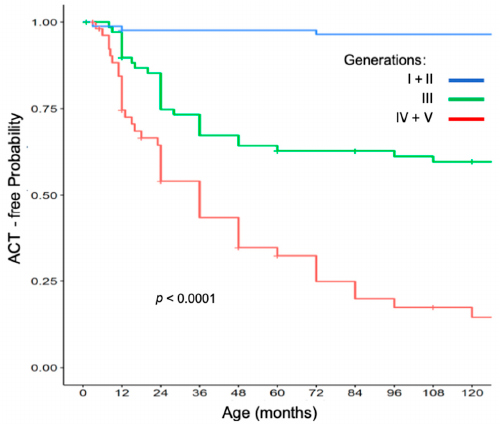
Figure 3. ACT-free probability in the 2006-C